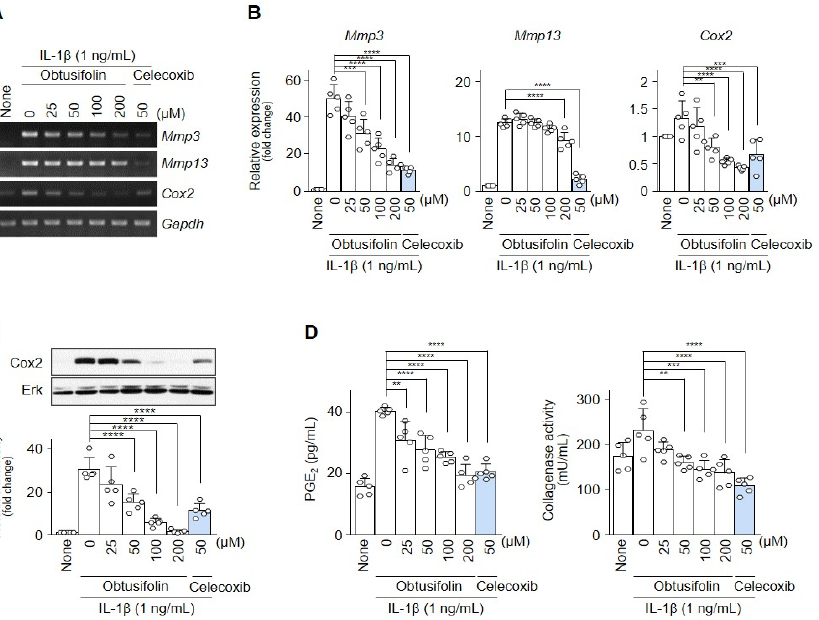
Figure 2. Obtusifolin downregulated Mmp3, Mmp13, and Cox2 expression in chondrocytes. Chondrocytes treated with IL-1 β (1 ng/mL) for 24 h were co-treated with obtusifolin at the indicated concentrations and celecoxib (50 μ M/mL) ( A , B , C ). The expression levels of Mmp3, Mmp13, and Cox2 were determined by RT-PCR ( A ) and qRT-PCR ( B ). Protein levels were determined by Western blotting ( C , upper) and densitometry ( C , lower). Collagenase activity and PGE 2 level were meas- ured at each concentration ( D ). Data were analyzed using the one-way ANOVA. The values of each group ( n = 5) are shown as mean ± SEM; * p < 0.05, ** p < 0.01, *** p < 0.001, and **** p < 0.0001.